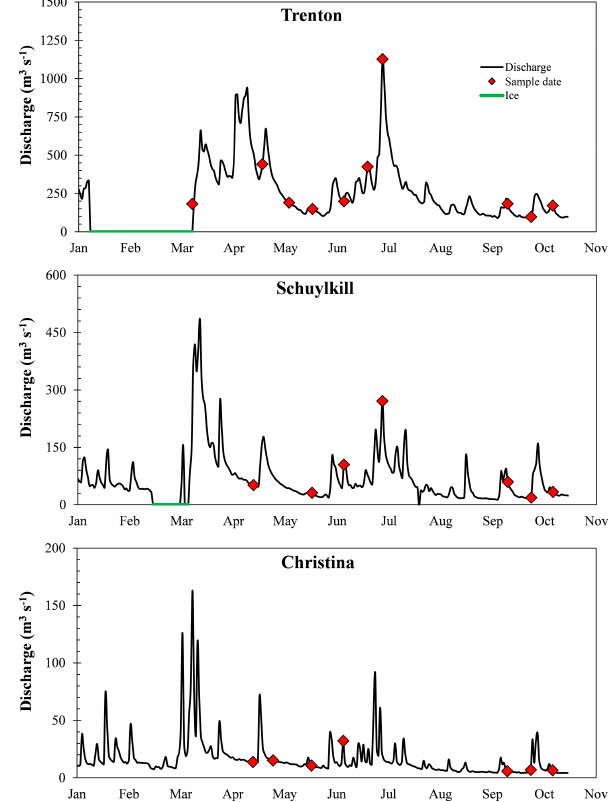
Figure 2. Daily discharge at the Delaware (Trenton), Schuylkill, and Christina rivers from March to October 2015. Note the different scales used for each river. Red diamonds indicate exact sampling dates. Green lines are when river waters were